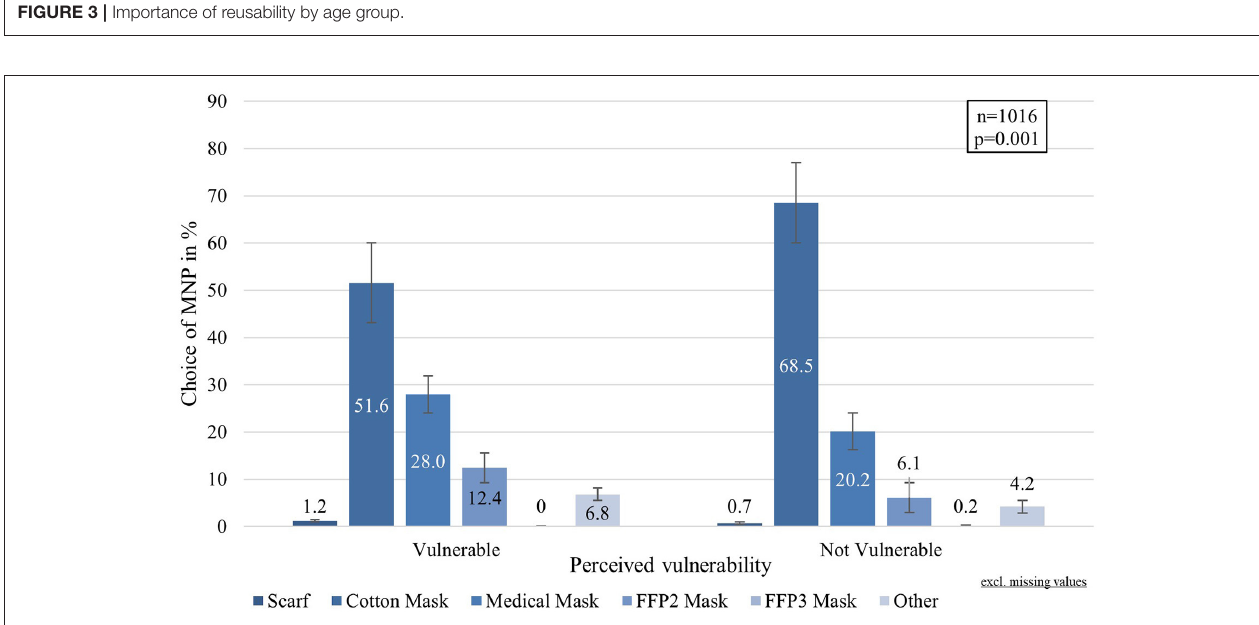
FIGURE 3 | Importance of reusability by age group.